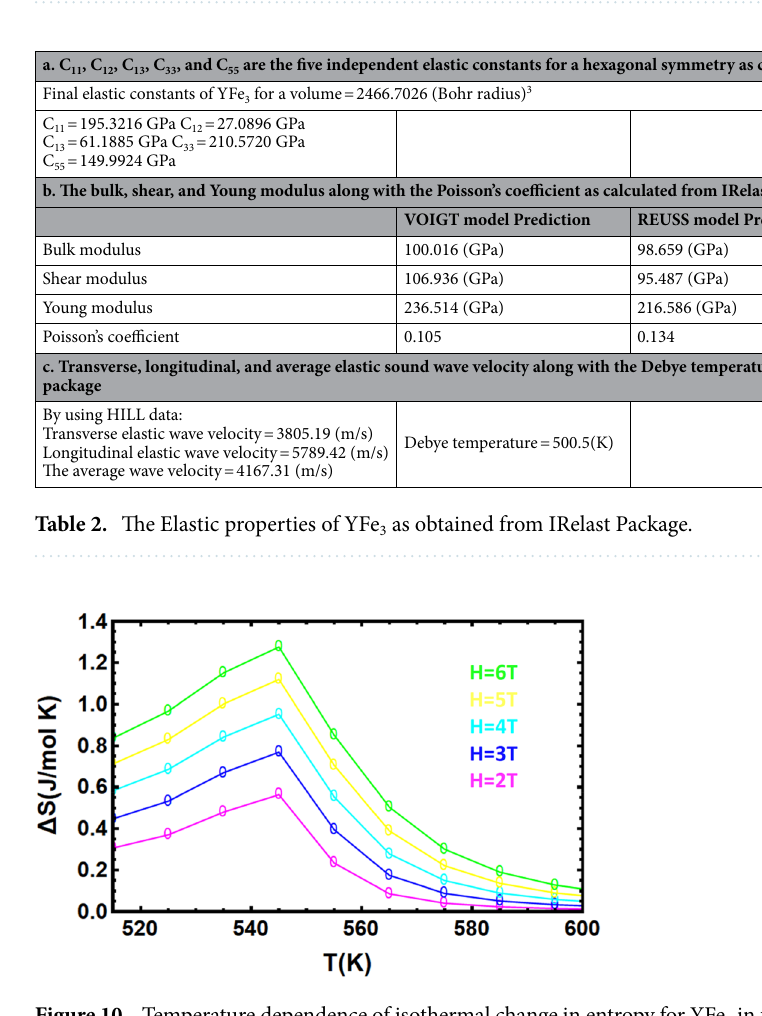
Figure 9. The calculated magnetic entropy of HoFe 3 in different fields vs. temperature.